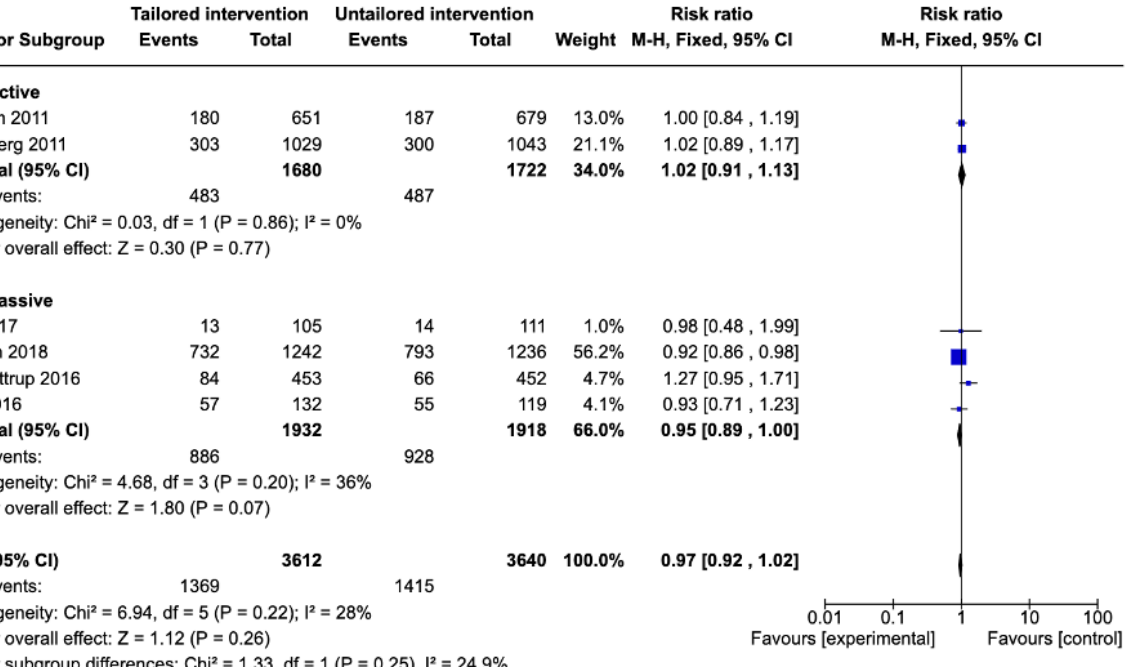
Figure 6. Comparison of attrition between tailored and untailored conditions at 12-month follow-up by control